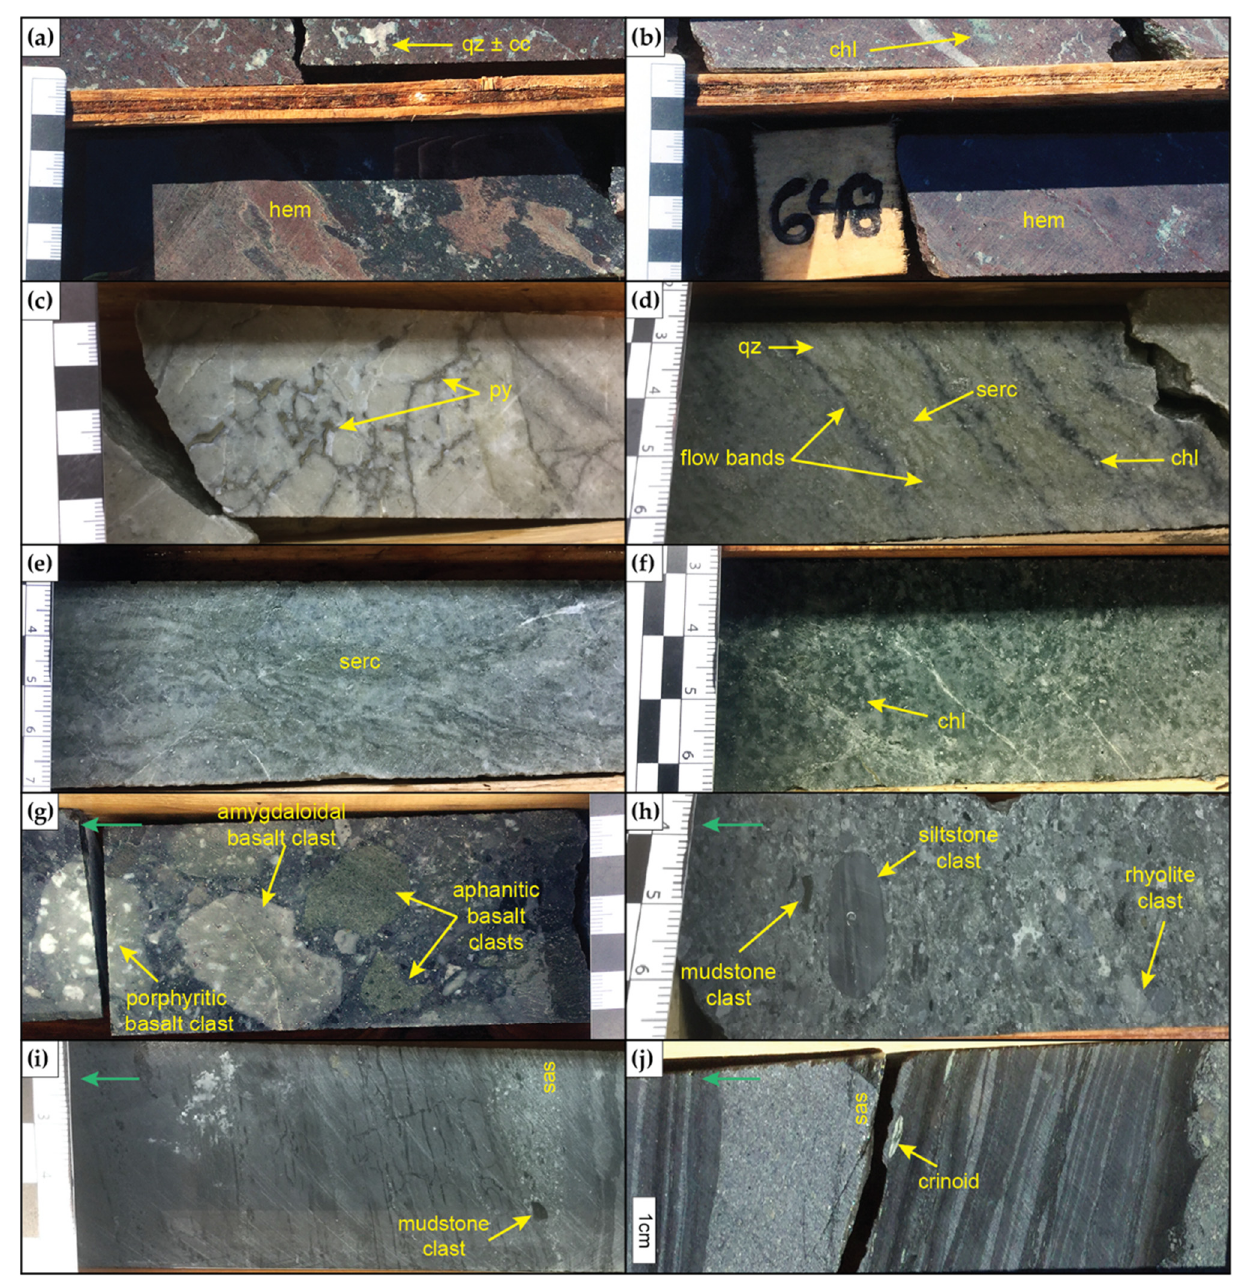
Figure 5. Igneous and epiclastic lithologies at the A6 Anomaly—Part I, ( a , b ) Hematite ± chlorite altered basaltic tuffs to lapilli tuffs, partly with quartz ± calcite filled amygdules occurring below altered felsic flows (BR-65), ( c – f ) Quartz-sericite ± chlorite ± pyrite altered felsic flows occurring beneath the retreating glacier, ( c ) silicified felsic flow with pyrite (BR-79), ( d ) Quartz-sericite-chlorite altered felsic flow with flow bands of chlorite and sericite (BR-82), ( e ) Quartz-sericite altered massive felsic flow (BR-82), ( f ) Quartz-sericite-chlorite altered massive felsic flow (BR-82), ( g ) Polymictic, poorly sorted cobble conglomerate with subround amygdaloidal, porphyritic, and aphanitic clasts in mudstone matrix conglomerate are not graded; green arrow depicts stratigraphic (BR-35), ( h – j ) epiclastic sequence ranging from conglomerate to siltstone, ( h ) Polymictic, poorly sorted pebble conglomerate with relatively well rounded clasts (siltstone, mudstone, rhyolite), conglomerate is not graded; green arrow depicts stratigraphic up (BR-87), ( i ) Finely bedded siltstone (grey variations) with medium- to coarse-grained sandstone bed containing polymictic epiclastic, subangular clasts including mudstone, sandstone bed is not graded; green arrow depicts stratigraphic up (BR-87), ( j ) Fine- to medium-grained, non-bedded sandstone alternating with thin carbonaceous and fossil-bearing siltstone to mudstone beds; green arrow depicts stratigraphic up (BR-65). Abbreviations: cc—calcite, chl—chlorite, hem—hematite, py—pyrite, qz—quartz, sas—sandstone, serc—sericite.